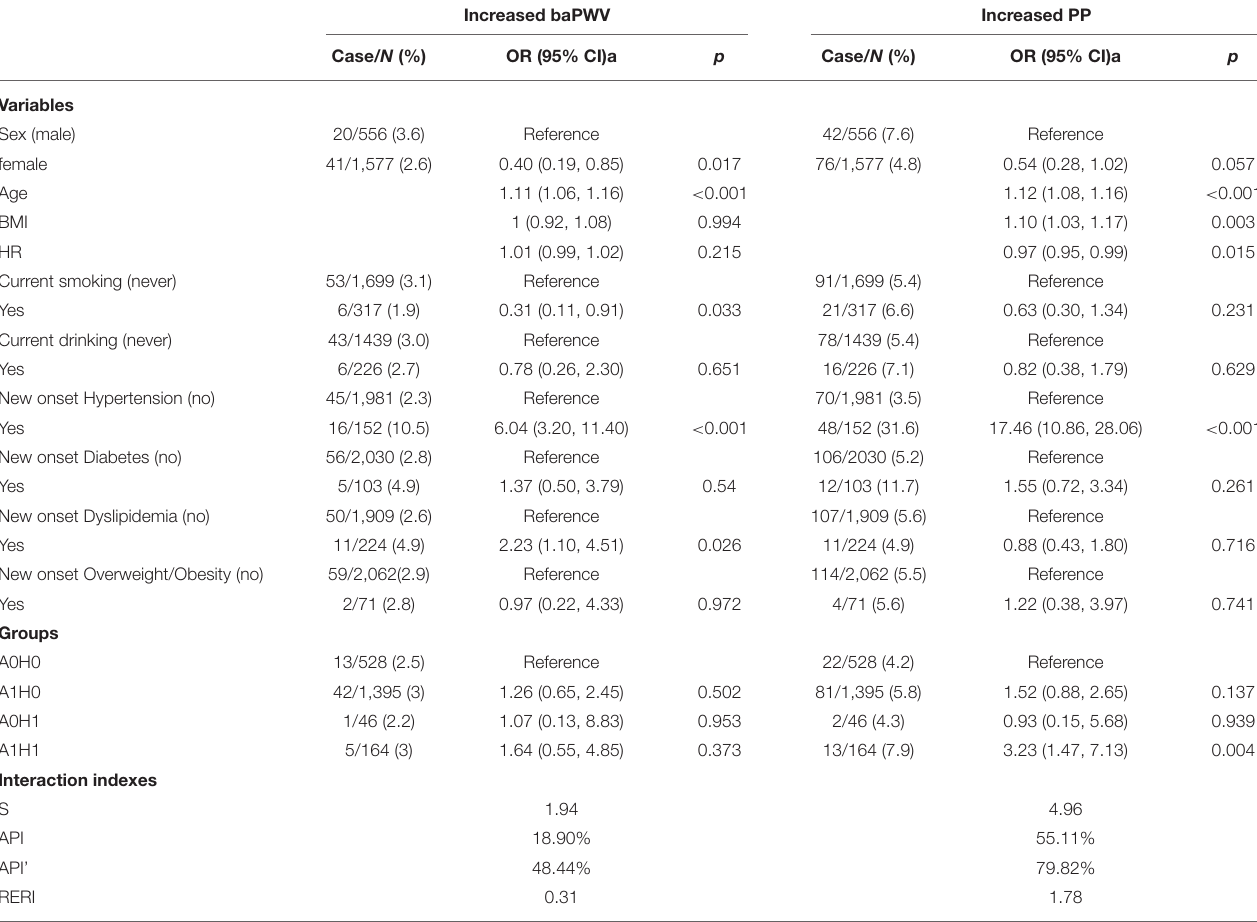
TABLE 3 | Association between groups of different hyperfiltration and metabolic status and outcomes in all